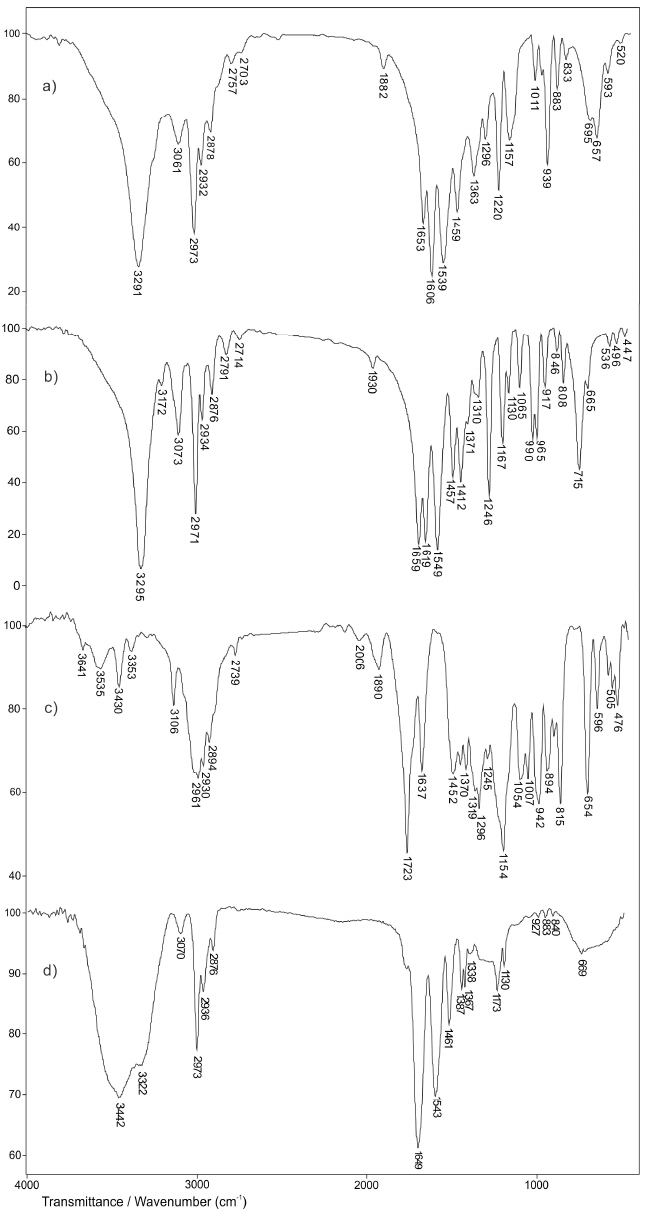
1653 cm − 1 (Amide band I) and 1539 cm − 1 (Amide band II). It can be assumed that